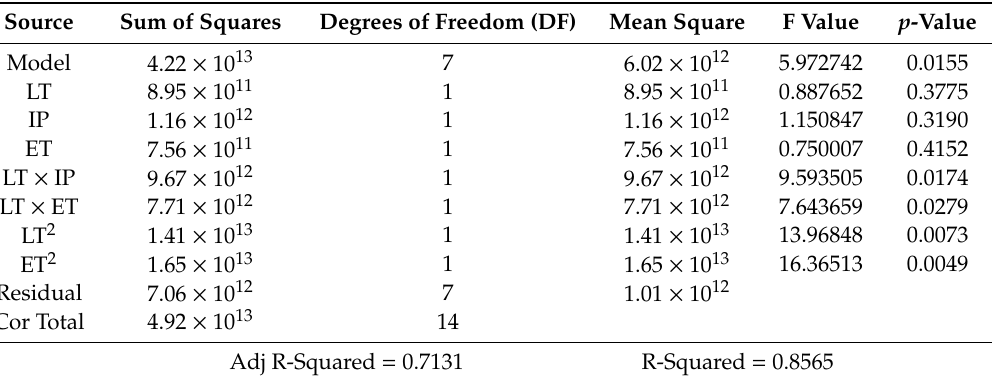
Table 4. Analysis of variance